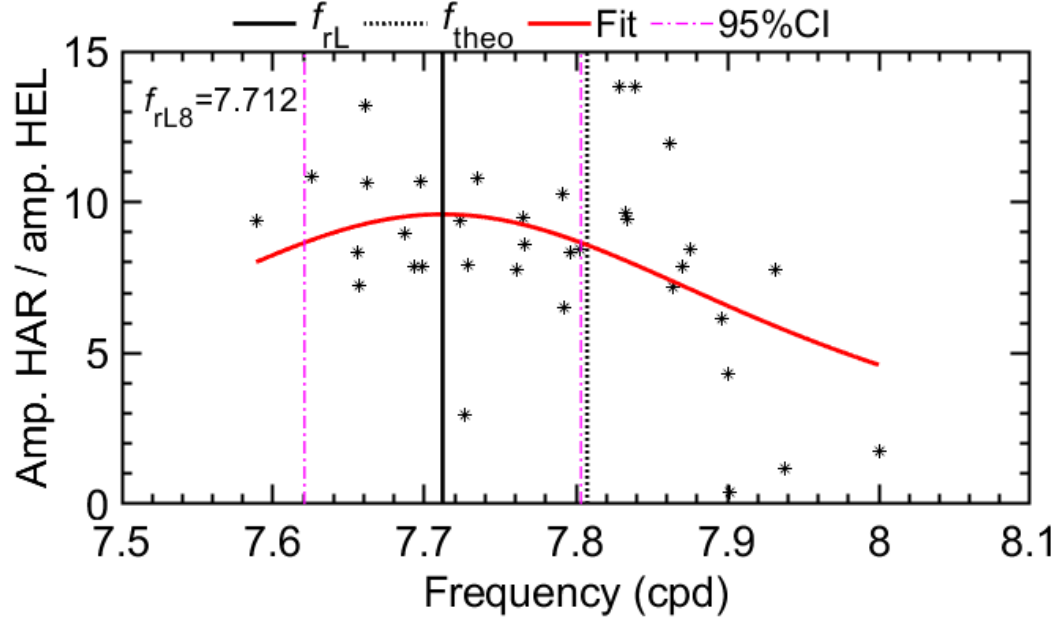
Figure 10. Degrees of amplification between gauge Helgoland in the German Bight and gauge Harburg at the reflector in the port of Hamburg for eighth-diurnal tidal constituents. Additionally shown are the resonance frequency calculated via a three-parameter Lorentzian function-fit f rL and the theoretical frequency f theo for the system length to wavelength ratio of 5/4 (5 × 1.5615 cpd).